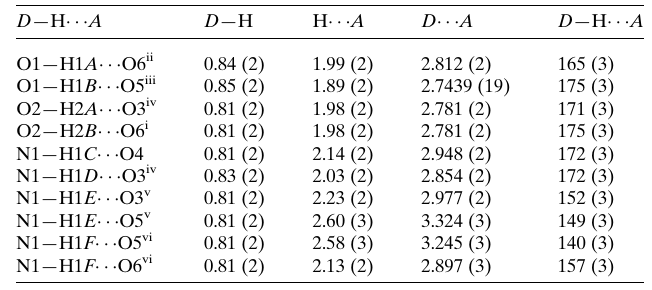
Table 2 Hydrogen-bond geometry (A˚ , (cid:5) ).